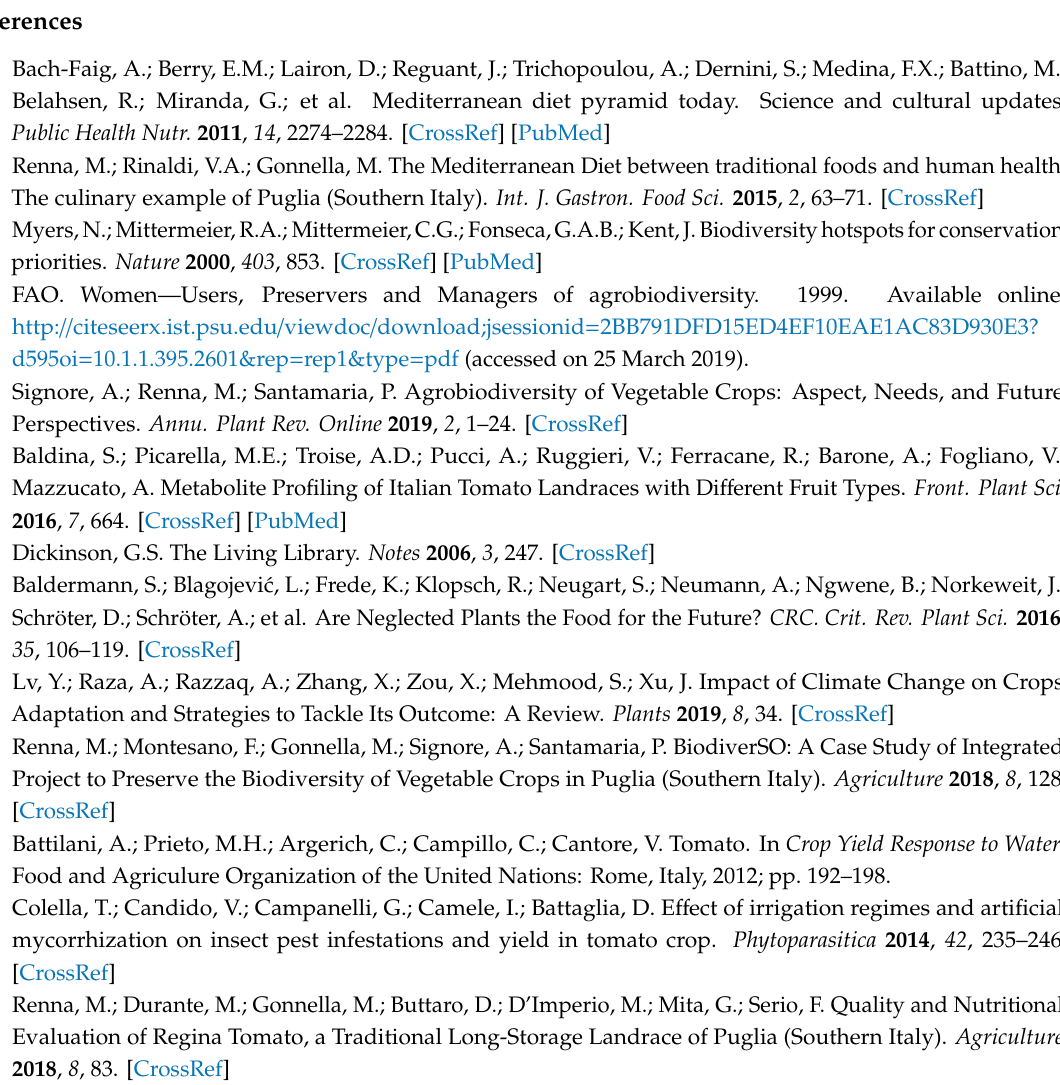
Table S1: Pearson correlation matrix for the physical and chemical observations analyzed in the Principal Component